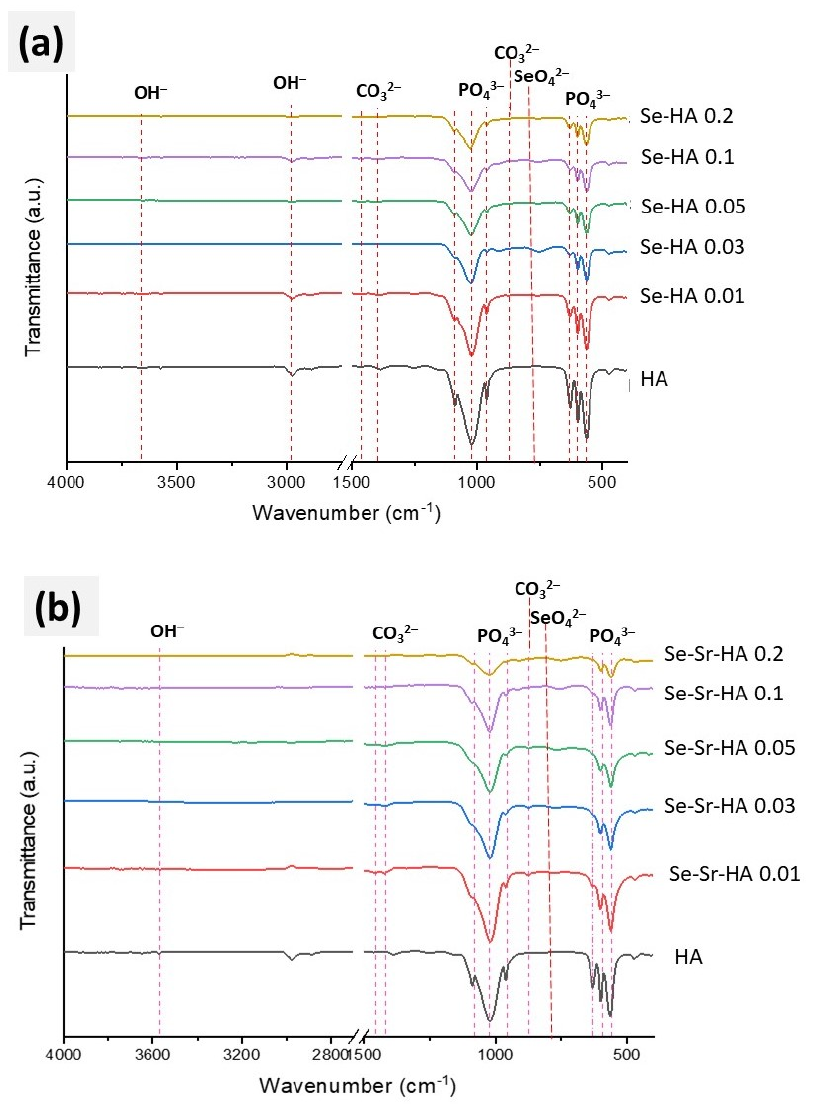
Figure 2. FTIR spectra of Se-HA ( a ) and Se-Sr-HA ( b ) at different Se and Se/Sr molar ratios sintered at 900 °C.